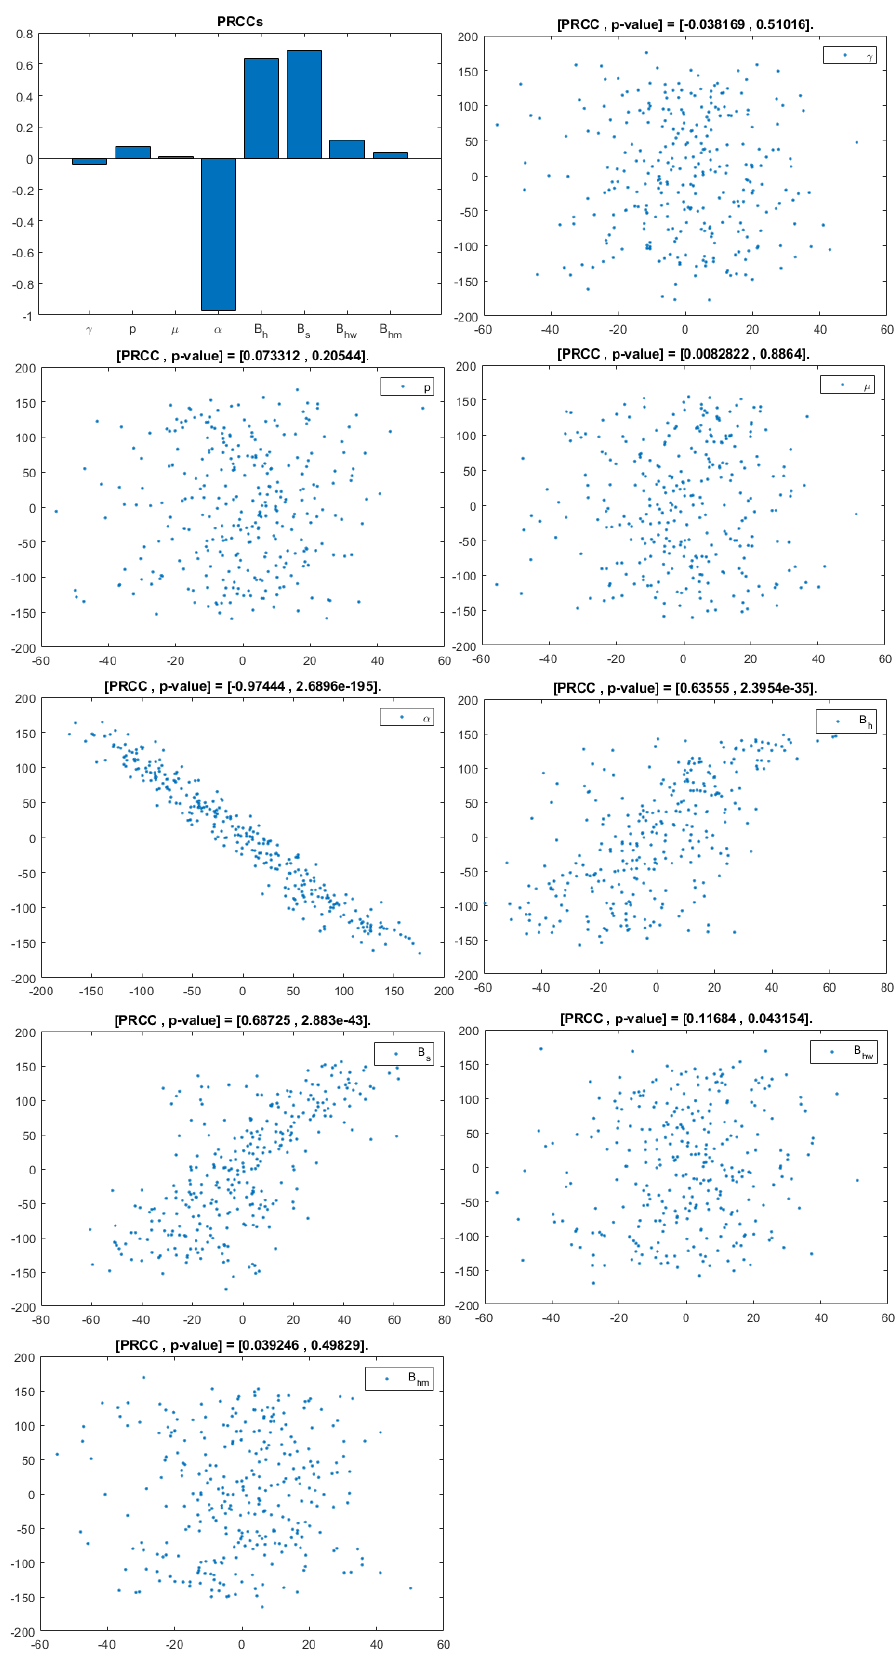
Figure 5. PRCC– Diagram and Scatterplot for each Parameter in Table 2 with respect to Untreated Infected Women, I w